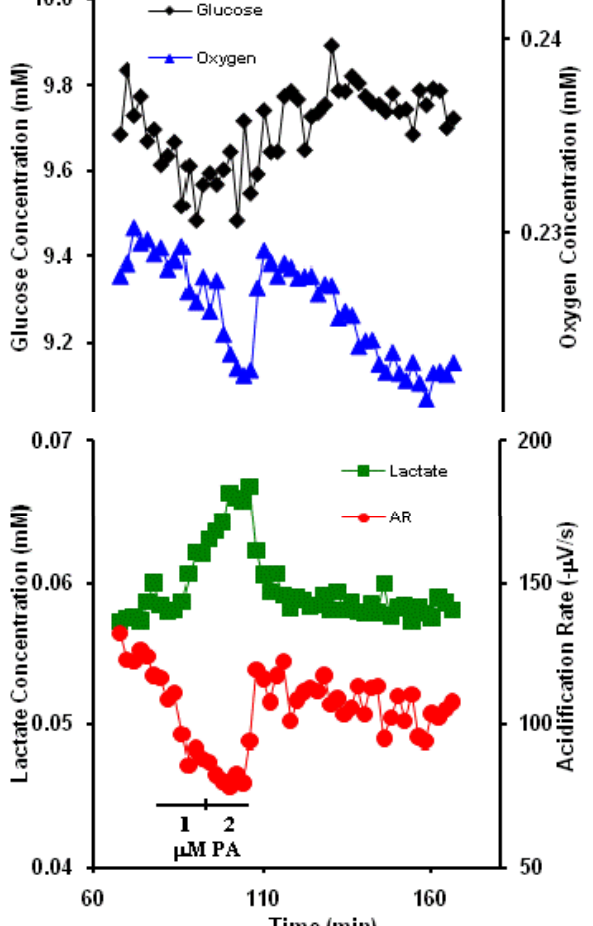
Figure 4. Representative RAW macrophage response to 1 and 2  M anthrax